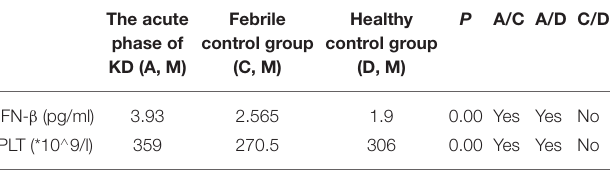
TABLE 7 | Logistic regression analysis and AUC for IFN- β and PLT combined detection at acute and subacute phase of Kawasaki disease. Hosmer & AUC Youden Sensitivity Lemeshow test index